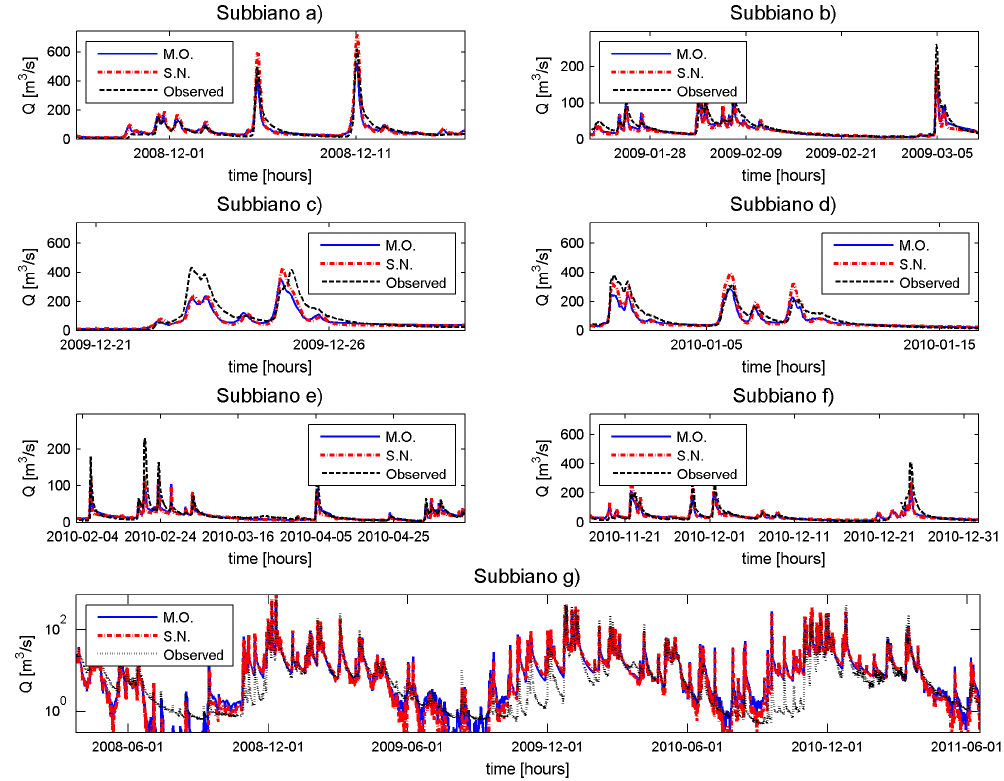
Figure 16. Observed streamflow for the Casentino basin compared with simulations obtained using M. O. and S. N. parameter sets for the period 2008 to 2011. The bottom subpanel shows the entire period with log scale on y axis. Time is reported on x axis and streamflow on y axis. The other subpanels show the main flood events with linear scale on y axis.